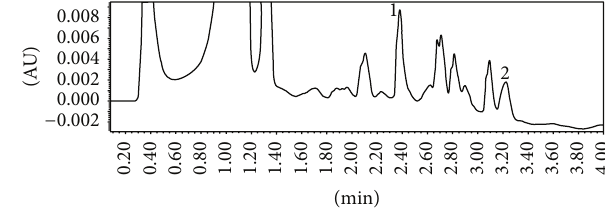
Figure 2: Typical chromatogram of human plasma sample spiked with (1) afatinib at 250 ng/mL (RT: 2.38 min) and (2) diclofenac at 250 ng/mL (RT: 3.22 min).